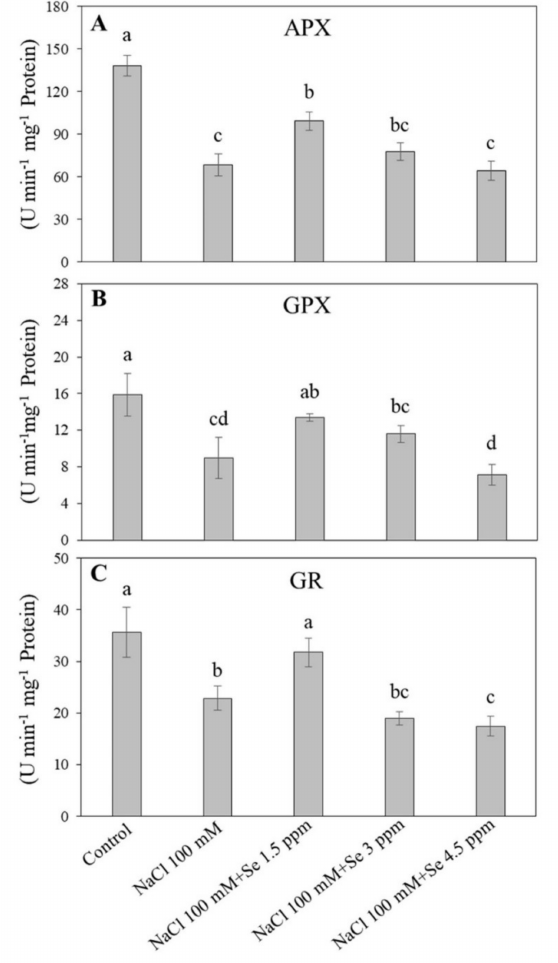
Figure 4. E ff ect of selenium (Se) fertilization on ( A ) ascorbate peroxidase (APX); ( B ) glutathione peroxidase (GPX); and ( C ) glutathione reductase (GR) in leaves of black gram plants under salt stress. Values are mean ± standard error ( n = 3). Di ff erent letters in vertical columns show a significant di ff erence. A comparison of mean was confirmed by LSD at p <